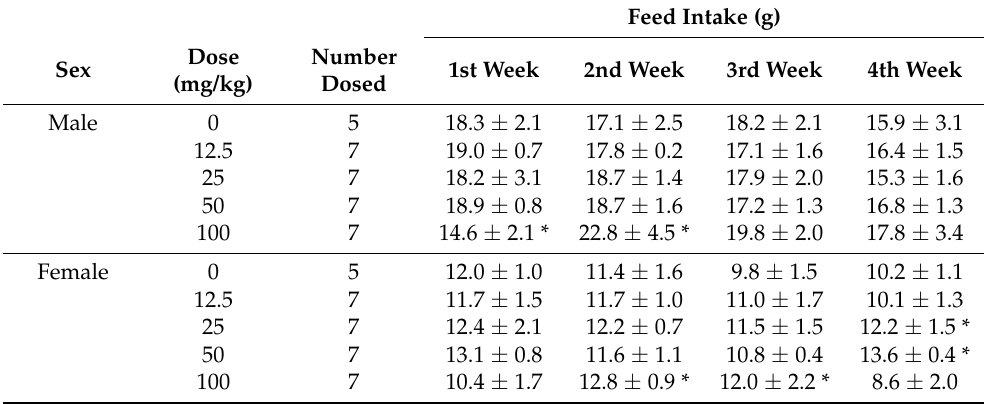
Table 3. Feed intake for the 28-day repeated oral toxicity study.